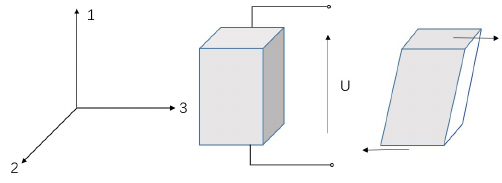
Figure 2. Schematic diagram of the PZT (shear